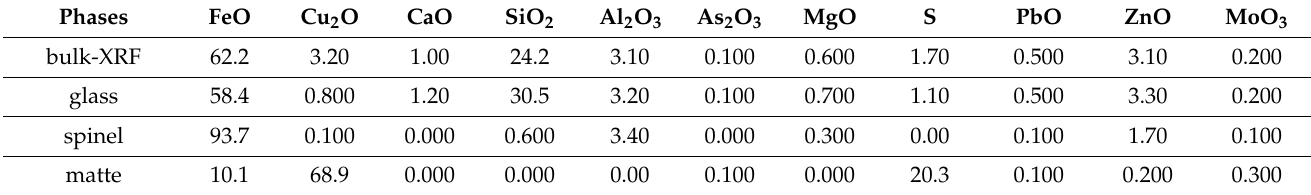
Figure 4. Typical microstructures of quenched smelting slag from Fangyuan BBF ( a ) (Reprinted with permission from ref. [7]. Copyright 2021 John Wiley and Sons) and a flash furnace ( b ). Table 3. Compositions of the phases present in a quenched BBF slag measured by EPMA and bulk composition measured by XRF (wt%). Data derived from